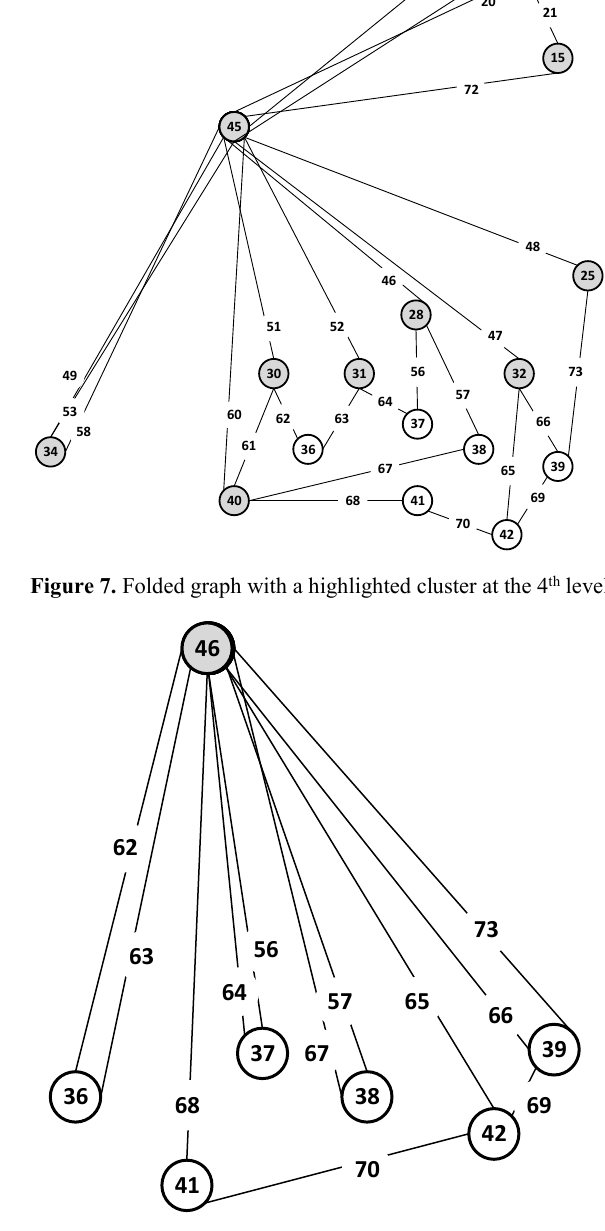
Figure 8. Folded graph with a highlighted cluster at the 5 th level The resulting graph contains vertex 46 and its Neghbors ( cNode ) = 36, 41, 37, 38, 42, 39 (Fig. 8). The edge lists for the cluster of the 5 th level is the following: Cluster 5-8 = (46, 36), (46, 37), (46, 39), (46, 38), (46,